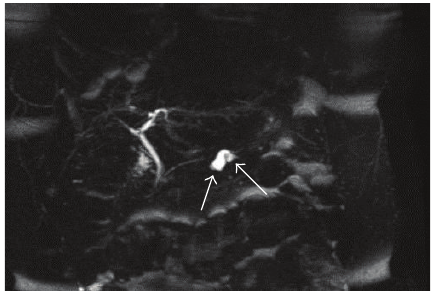
Figure 2: BD-IPMN in a 67-year-old female. MRCP acquisition clearly shows a cystic lesion centred on the body of pancreatic parenchyma (white arrows). The cyst shows a curved tubular shape. Due to the absence of high-risk-stigmata and worrisome features, lesions were safely